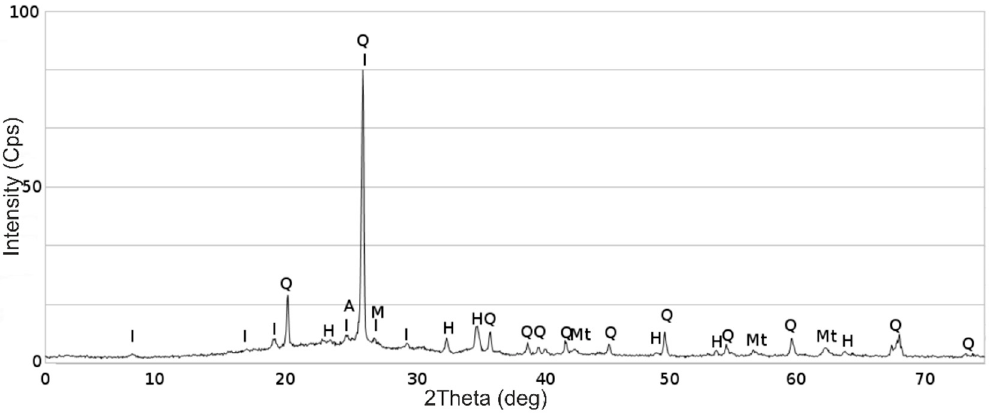
Figure 6. X-ray diffraction pattern of fly ash from the combustion of bituminous coal from the Janina deposit. Q—quartz, I—illite, H—hematite, A—anhydrite, M—microcline, and Mt—magnetite.